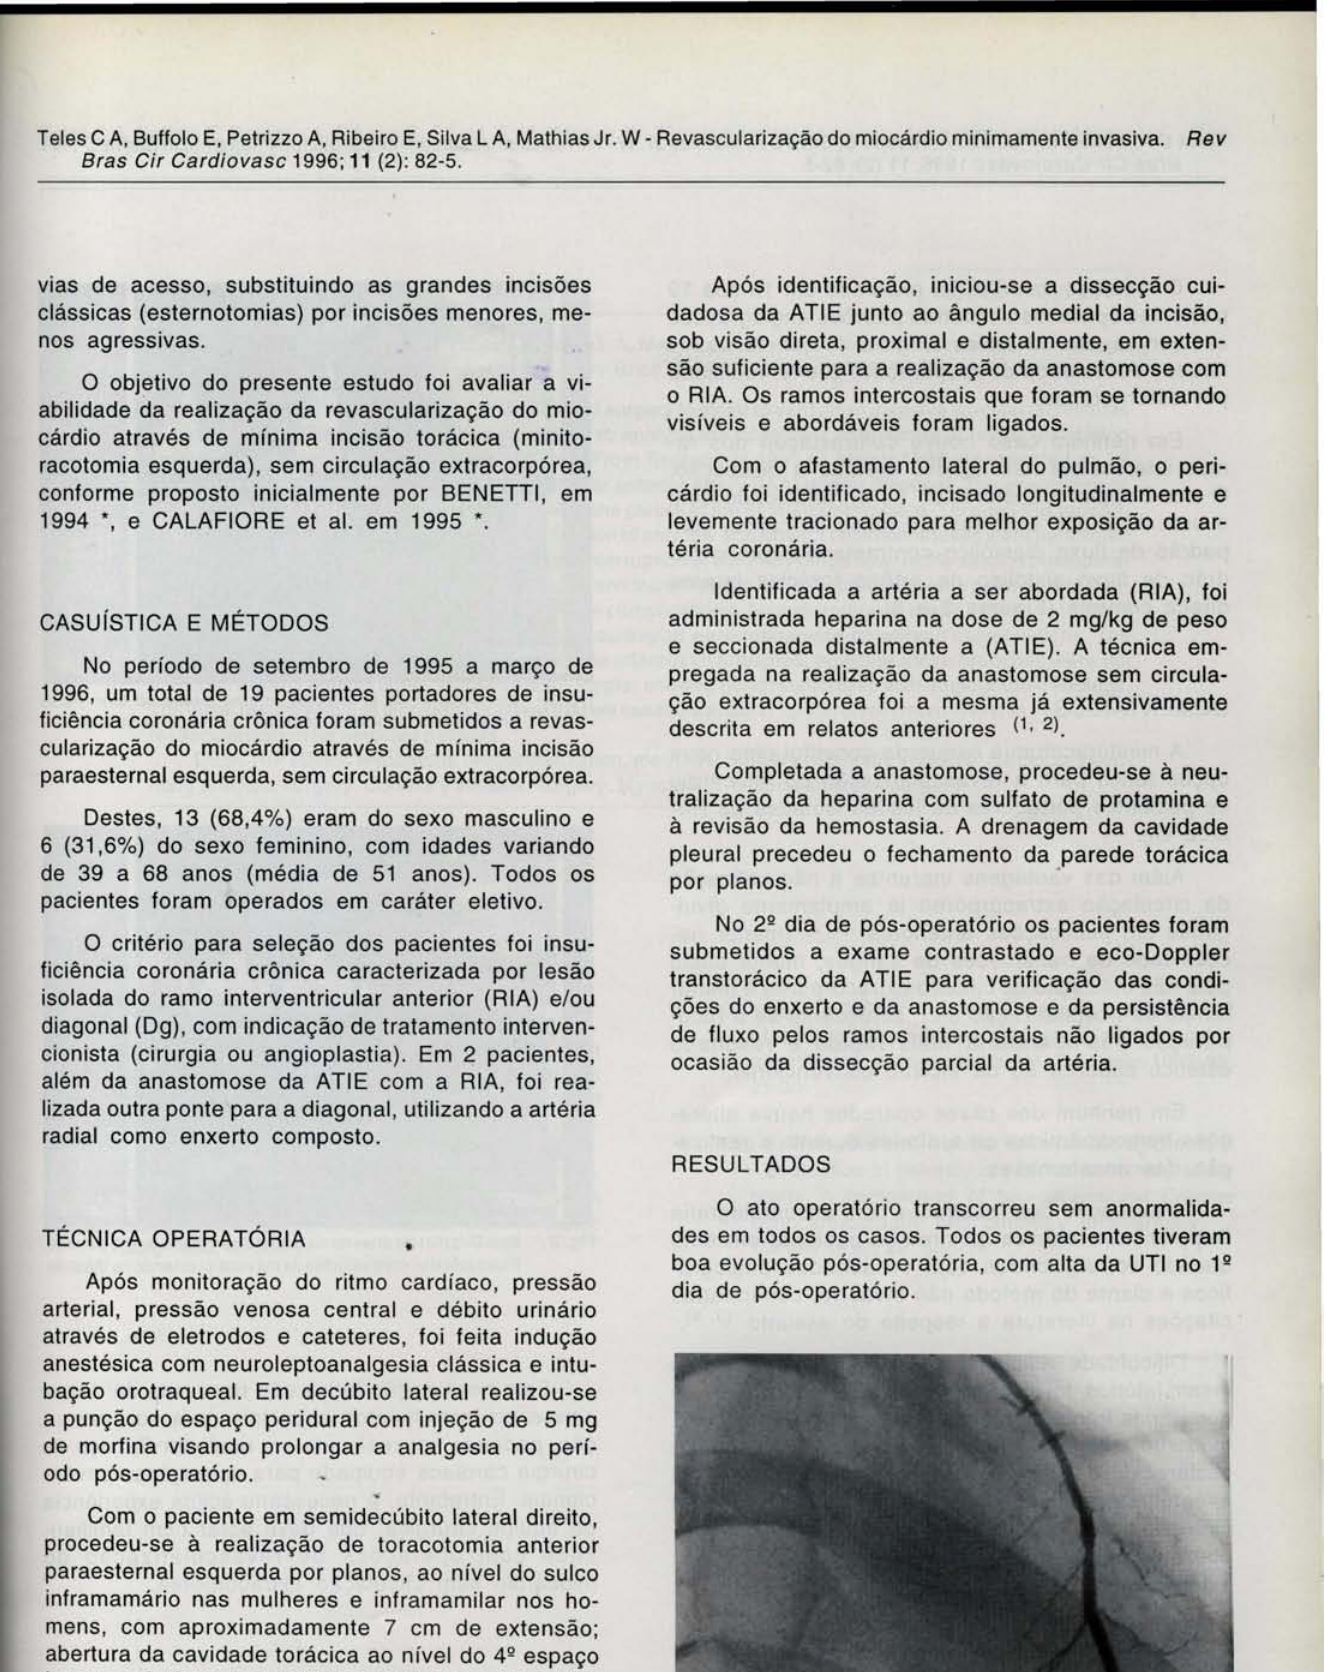
Fig. 1 · Angiografia de controle pós-operatório, contrastando a arté ria torácica interna esquerda (ATI E) e ramo interventricular anterior